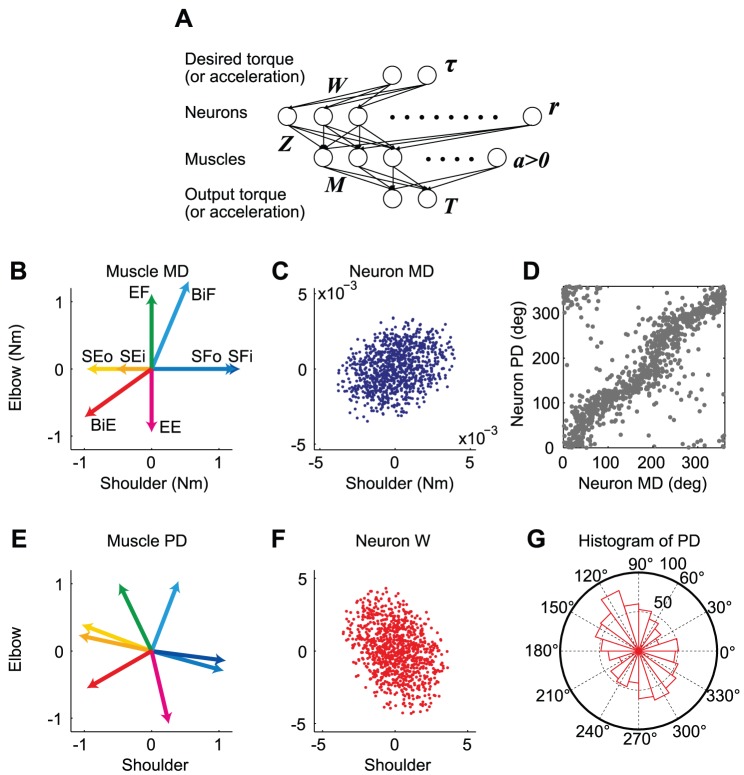
Simulation results for the shoulder and elbow torque exertion task.(A) Neural network model with a muscle layer. The model consists of an input layer, a 2nd layer of 1000 neurons, a 3rd layer of 8 muscle groups at the shoulder and elbow joints, and an output layer. (B) The mechanical direction vectors (MDVs) for the 8 muscle groups. SFi, inner shoulder flexor (blue); SFo, outer shoulder flexor (light blue); SEi, inner shoulder extensor (orange); SEo, outer shoulder extensor (yellow); EF, elbow flexor (green); EE, elbow extensor (magenta); BiF, biarticular flexor (cyan); and BiE, biarticular extensor (red). (C) Distribution of the MDVs for the 1000 neurons in the 2nd layer. (D) PDs plotted against MDs. (E) PDs for the 8 muscles after learning. (F) Distribution of the synaptic weight (i.e., PDVs) for the 1000 neurons after learning. (G) Polar histogram of the neuron PDs after learning.